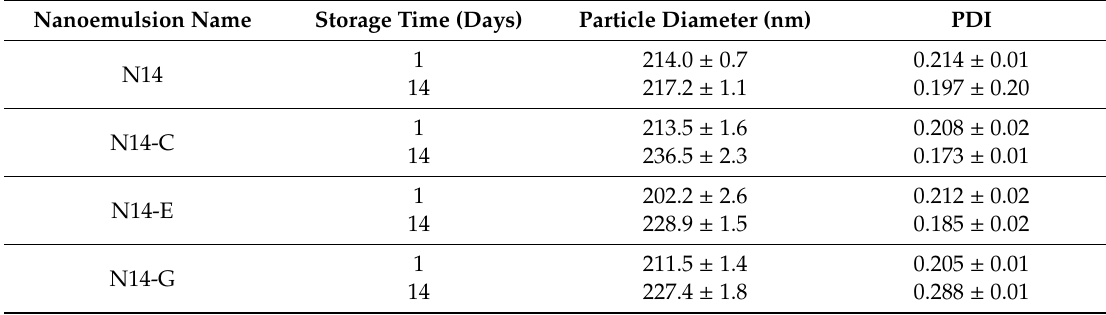
Table 3. Particle size and polydispersity index (PDI) of stable